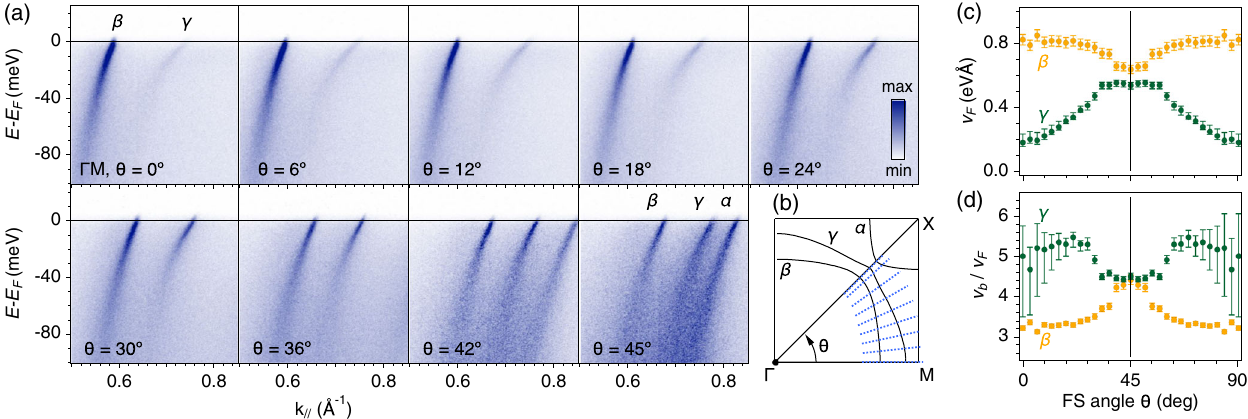
ˆ H 0 ˆ H DFT ¼ þ